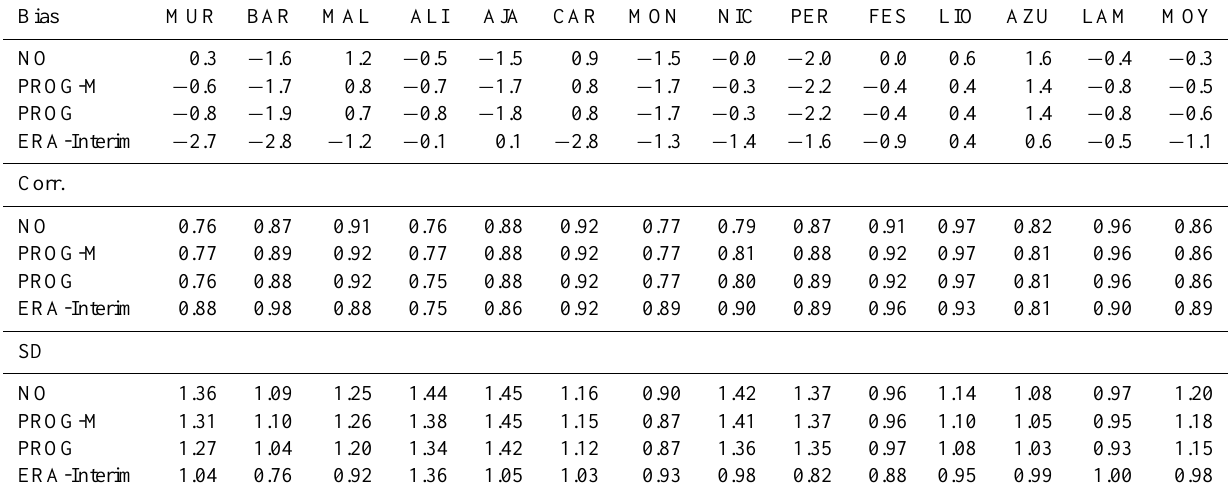
Table 5. Evaluation of daily 2m temperature simulated by NO, PROG-M, PROG and ERA-Interim against 13 ground-based measurements located around the Mediterranean basin, in terms of bias ( ◦ C), temporal correlation coefficient and standard deviation (SD) ratio.